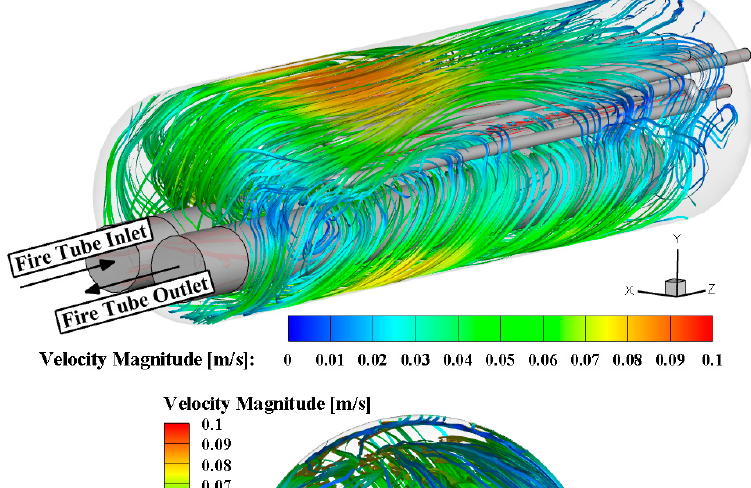
Figure 15. The variation in the fire tube outlet temperature against the inlet mass flow rate.